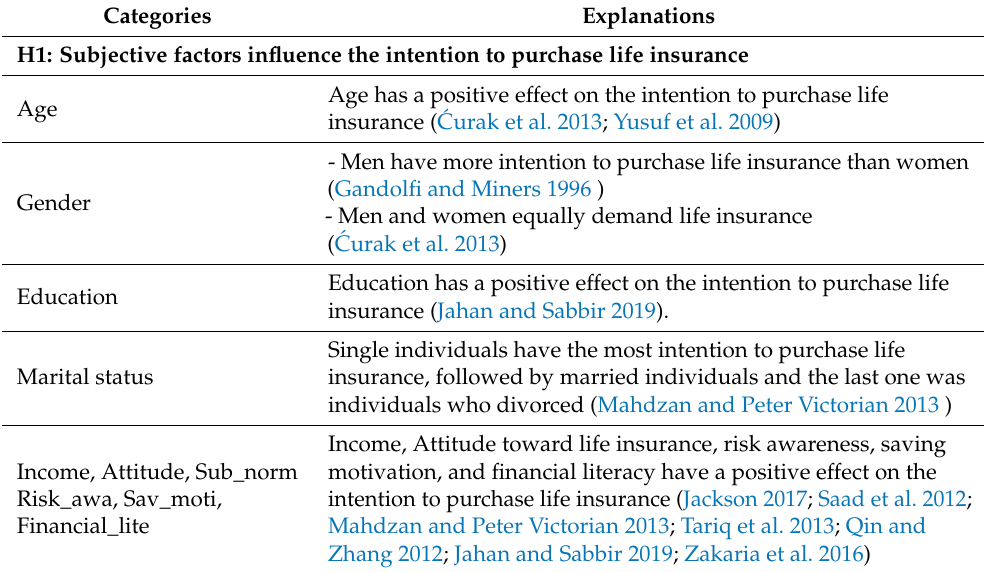
Table 1. Explanation of the